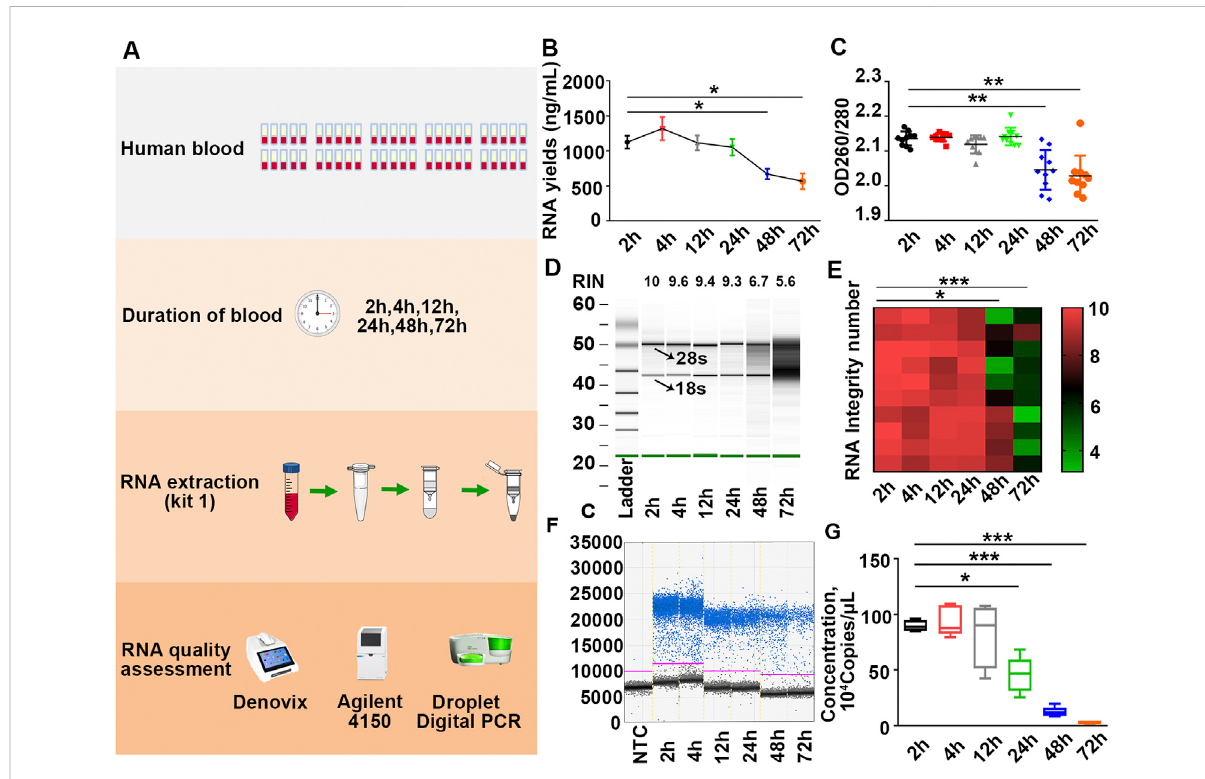
FIGURE 3 PlacingbloodatRTover12 hsigni fi cantlycompromisesRNAquality. (A) Schematicillustrationoftheexperimentalschedule. (B,C) Yields (B) and purity (C) of RNA in each group were measured by Denovix spectrophotometry. n = 60. (D) Representative electrophoretic gel-like image of RNA in each group. The arrows indicate 18 s and 28 s ribosomal bands. (E) Heatmap of RIN values of samples. n = 60. (F) Representative one-dimensional plots of droplets measured for fl uorescence signal emitted from β -actin in each group. (G) Number of β -actin copies in each group. n =